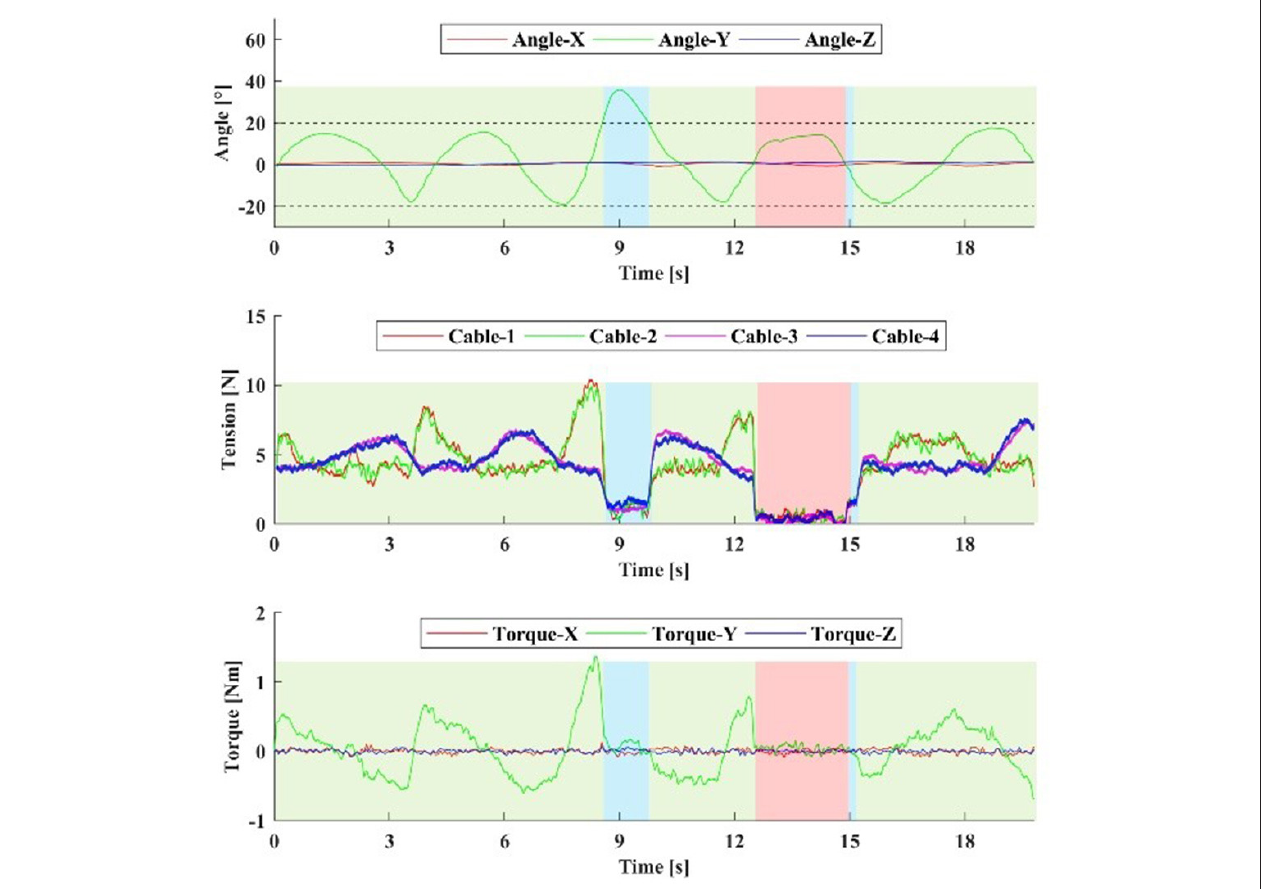
FIGURE 12 | The healthy subject performs a safety mode test. The damping coefficient B D is 1 Nm · s/rad. The subject actively exceeds the safe range near the 9ths, and then returns to the safe range. Near the 12ths, the drive system is powered off and the robot enters Safety Mode II. Then, the drive system is powered on near the 15ths, the robot returns to Normal Work Mode. The blue and red regions are Safe Mode I and Safe Mode II,